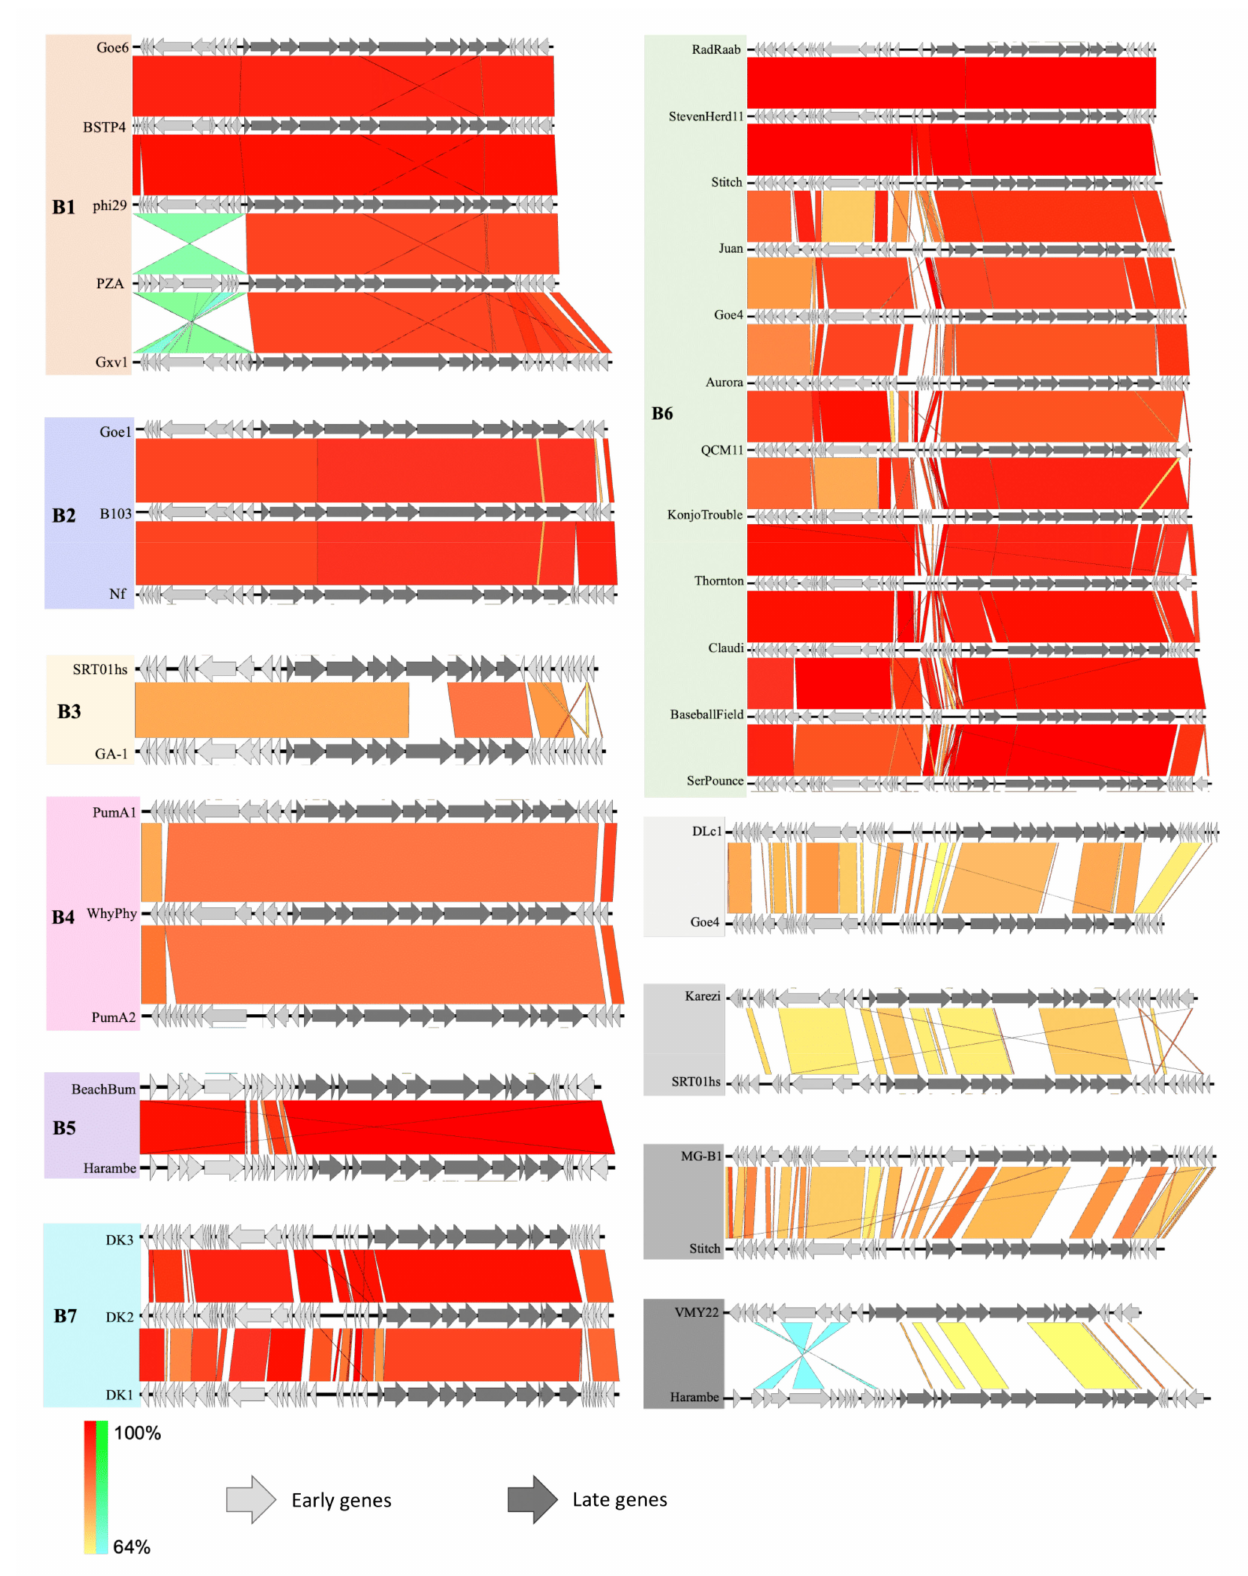
Figure 4. Genome map alignments of each cluster and singletons (shaded grey) with their closest relating phage. Color bar ranges from red to yellow, showing identities, and the blue to green shows homology in any inverted